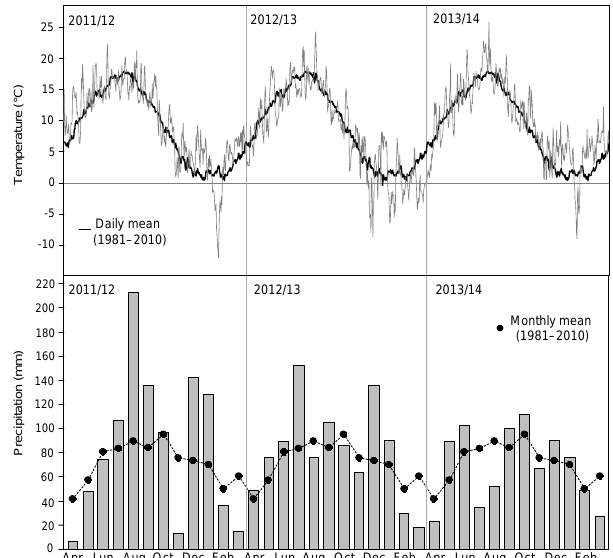
Figure 1. Daily mean air temperatures (grey line) and monthly mean precipitation sums (grey bars) during the study period (April 2011–March 2014) compared to the long-term